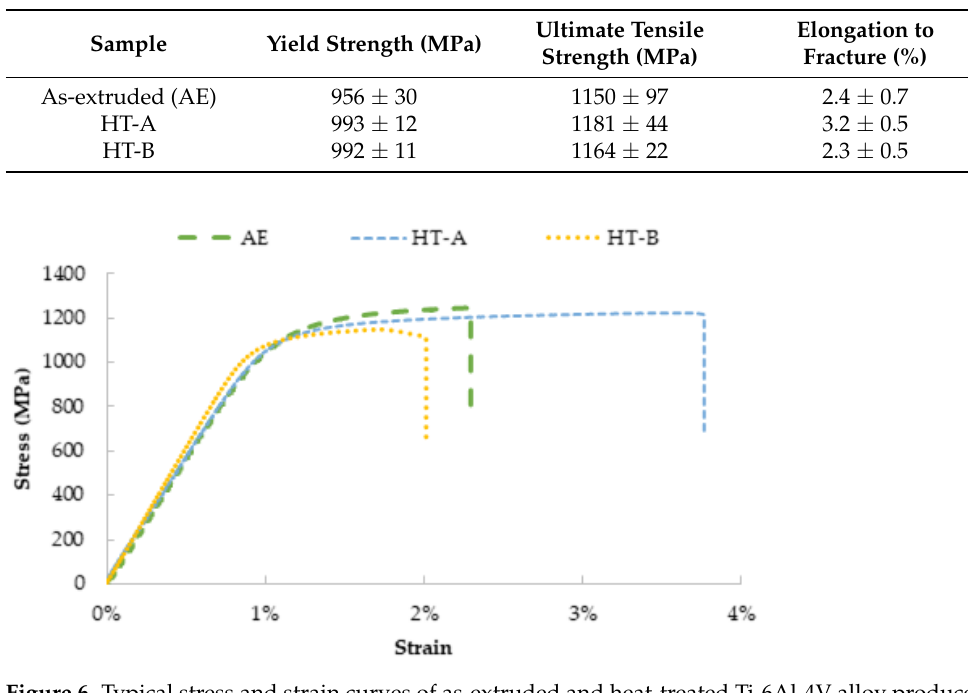
Table 3. Summary of average tensile properties obtained for as-extruded and annealed Ti-6Al-4V alloy prepared from blended powders using thermomechanical powder consolidation (TPC) route.